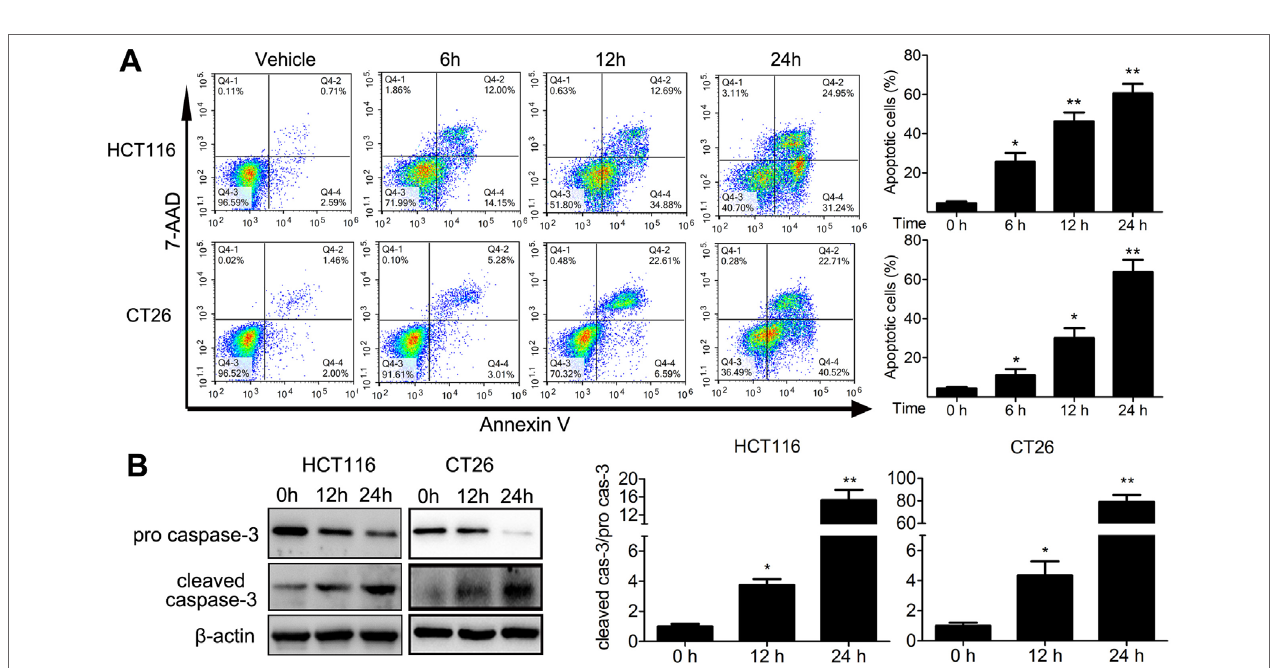
FIGURE 5 | Time-dependent effects of TFP on apoptosis in HCT116 and CT26 cells. (A) The cells were treated with 30 µM (HCT116) or 20 µM (CT26) TFP for the indicated time. The apoptosis were analyzed by FCM after Annexin V/7-AAD labeling. (B) After treatment for 12 and 24 h, expression levels of pro-caspase-3 and cleaved caspase-3 were detected in HCT116 (30 µM TFP treatment) and CT26 (20 µM TFP treatment) cells. Quantification of the results is shown on the right. *P < 0.05, **P <